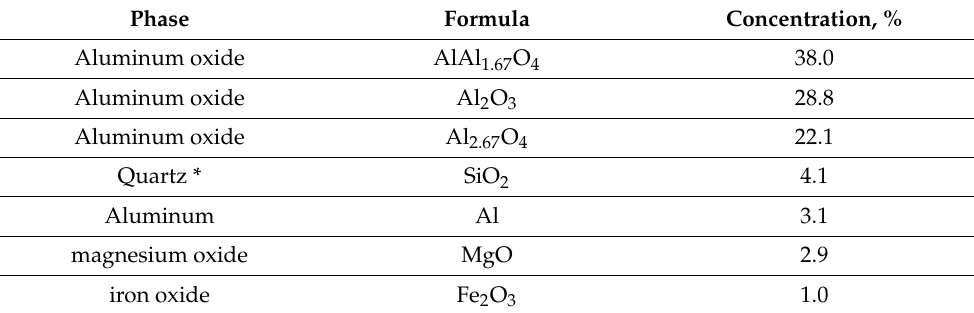
Table 8. Results of semi-quantitative X-ray phase analysis of slag.